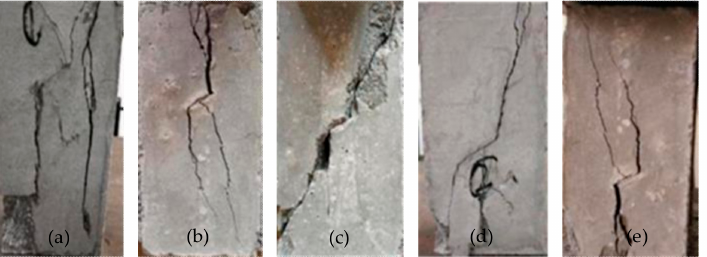
Figure 4. Crack morphology of rock-like specimens with different joint location with ( a ) top joint, ( b ) upper joint, ( c ) middle joint, ( d ) lower joint and ( e ) bottom joint.